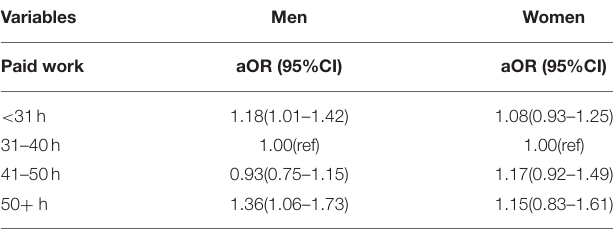
TABLE 3 | Relationship between paid work hours and SAH in Europe by gender.